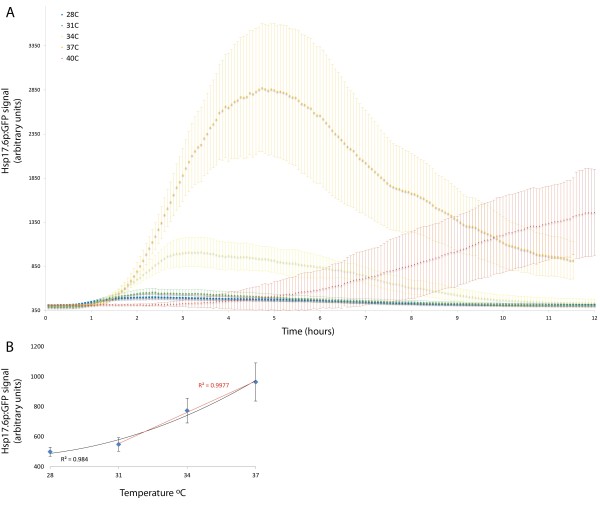
Induction kinetics ofHsp17.6p:GFP in response to heat shock temperatures from 28°C to 40°C. Plants were heat shocked for one hour at temperatures from 28-40°C and imaged every four minutes for at least 11:30 (A). The average intensity of the GFP signal from time points between 2:00–2:20 (1:00–1:20 after the end of heat shock) are plotted with either a linear regression (31-37°C, red) or a 2° order polynomial regression (28-37°C) (B). Error bars are +/- standard deviation.